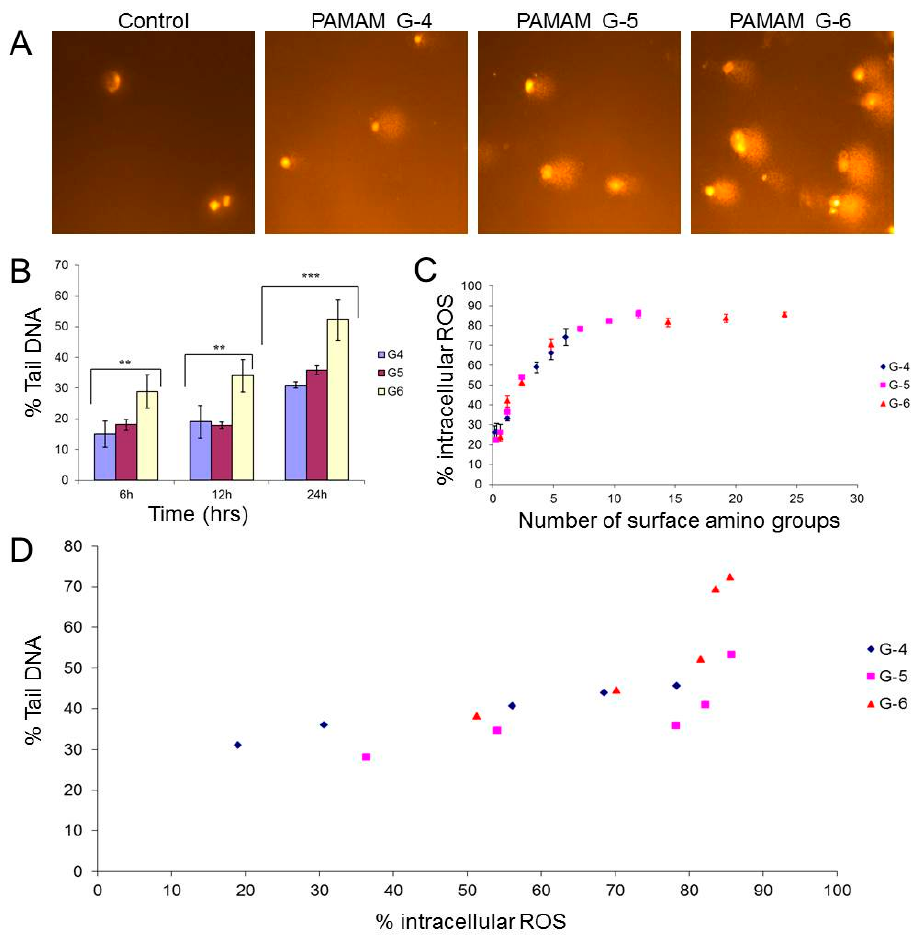
Figure 3. ( A ) Representative micrographs showing comets of PLHC-1 cells after 24 h exposure to PAMAM dendrimers (G4, G5, and G6) at a dose of 0.5 μ M concentration. ( B ) Generation dependent genotoxicity response of PAMAM dendrimers at 6, 12, and 24 h exposure at 0.5 μ M concentration, as represented by the %Tail DNA measured by the comet assay. *** Significant difference of genotoxicity response between G4, G5 and G6 ( p ≤ 0.05). ** Significant difference of genotoxicity response between G4, G6, and between G5, G6 ( p ≤ 0.05). ( C ) Plot showing the relationship between the intracellular ROS production and the molar volume X number of surface amine groups at 2 h exposure time period of 0.6 µ M concentration. ( D ) Relationship between DNA damage and intracellular ROS production upon exposure to PAMAM dendrimers G4, G5, and G6. Maximum DNA damage was observed at 24 h, and maximum ROS at 2 h. Figure reproduced with permission from reference [72].